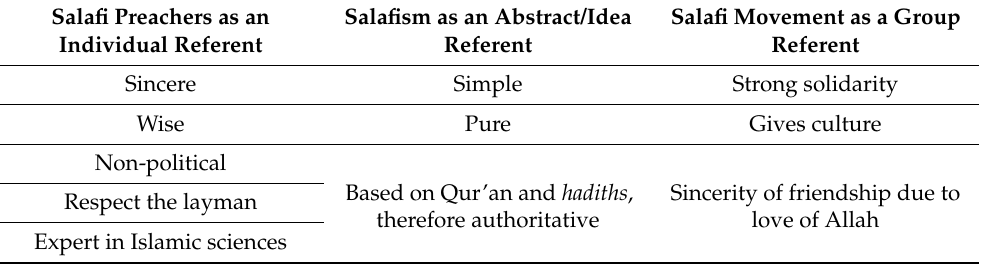
Table 1. Perception of the informants on the referent